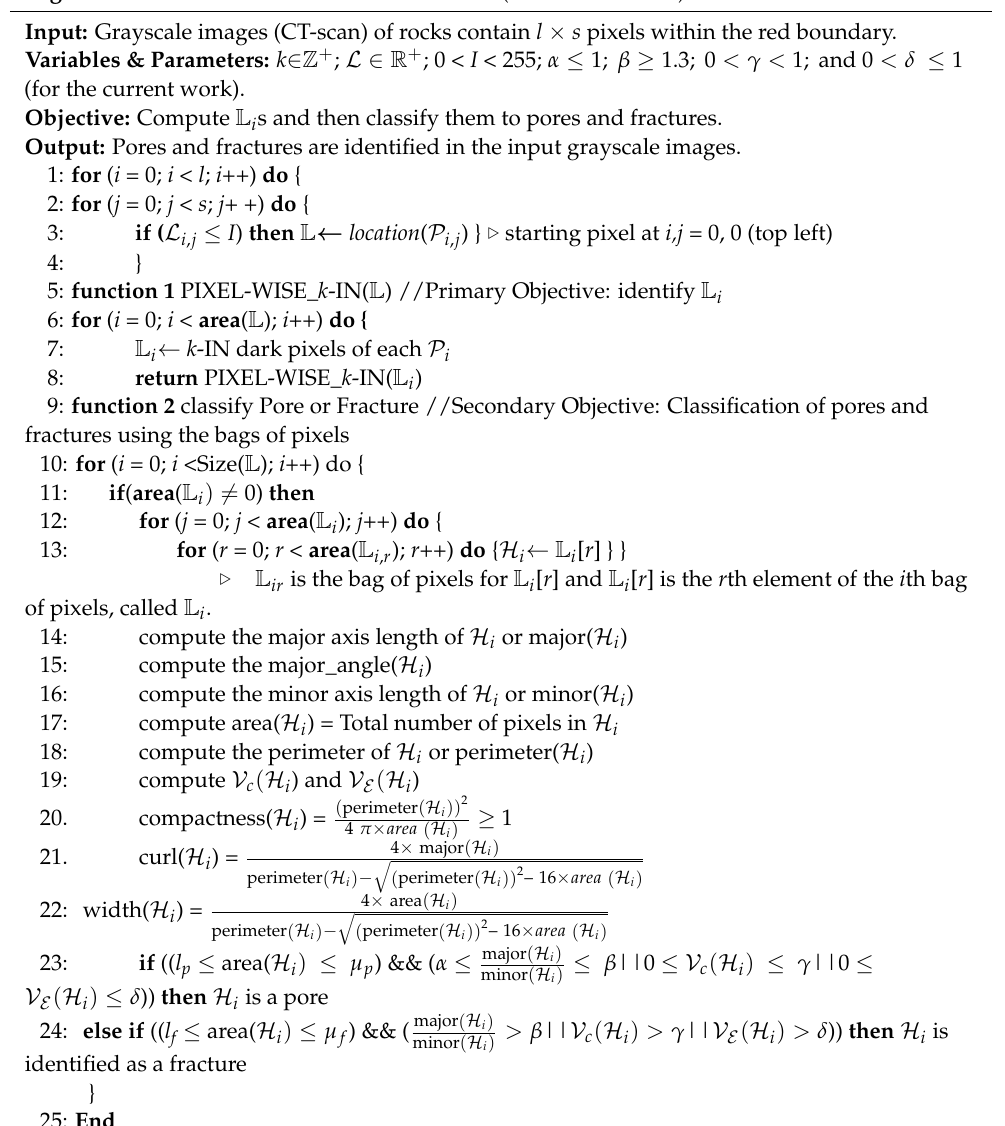
Algorithm 1 Pixel Classification Procedure